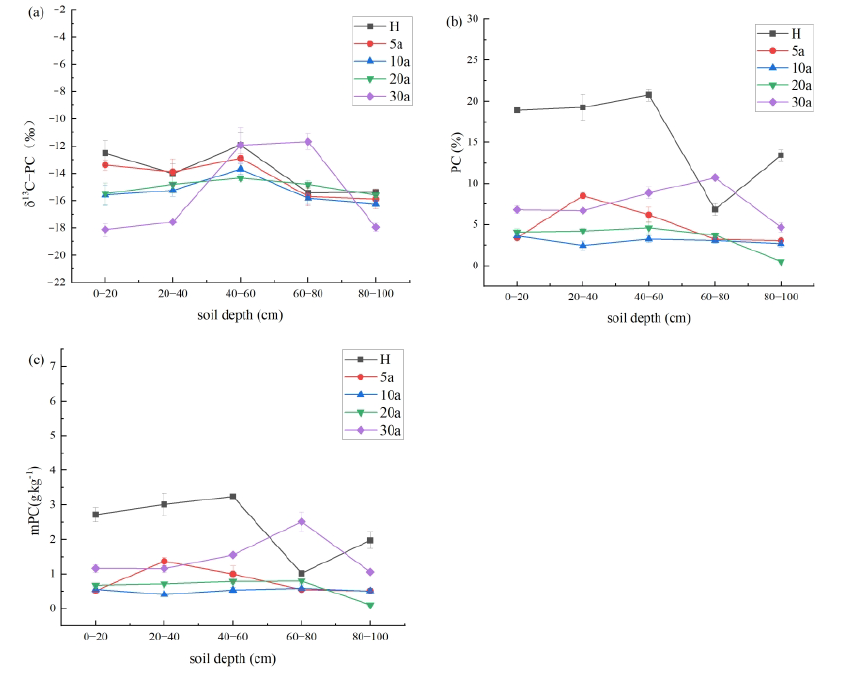
Figure 4. Stable carbon isotope characteristics of soil pedogenic carbonate ( a ) in cotton fields with different continuous crop years and its proportion ( b ) and content ( c ).